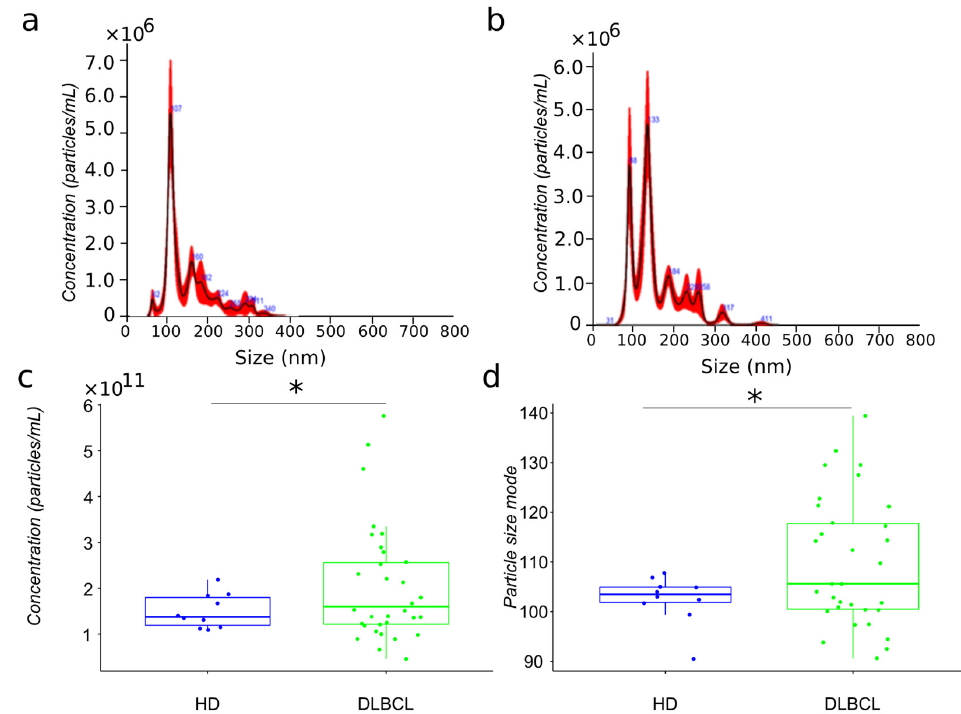
Figure 1. Biophysical characterization by nanoparticle tracking analysis of plasma EV samples from HD and DLBCL groups. Particle size distribution in representative samples of HD and DLBCL groups (( a , b ), respectively). Distribution of estimated particle concentration and particle size mode between DLBCL patients and HDs (( c , d ), respectively). * means significance.